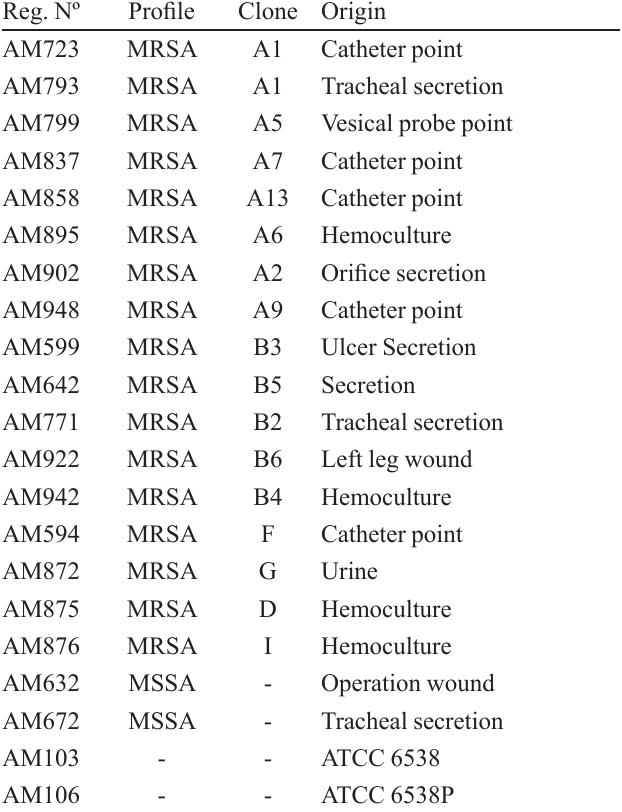
TABLE I - List of Staphylococcus aureus strains assayed Reg.